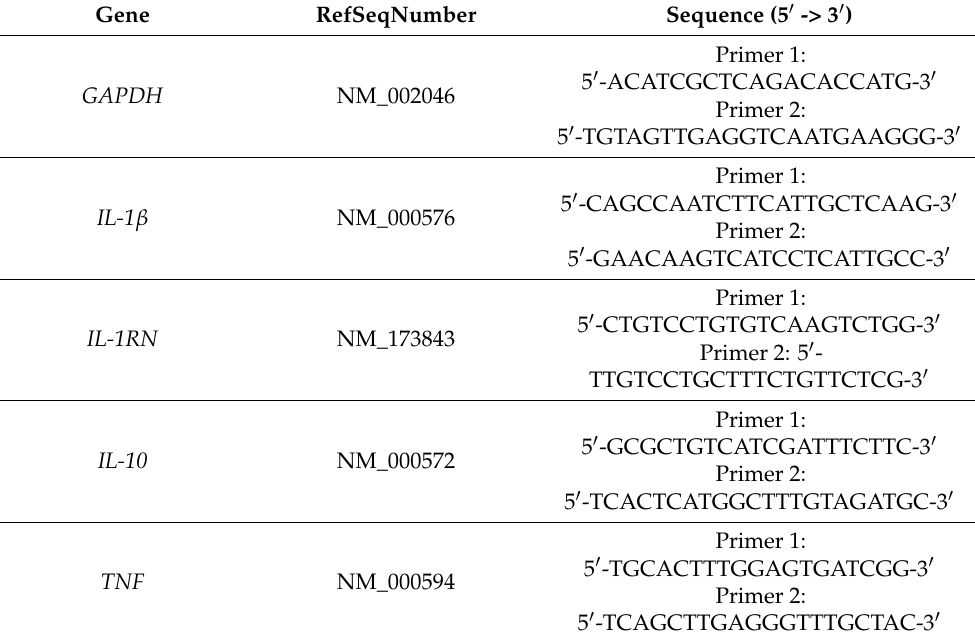
Table 1. Primer sequences used in real-time qPCR for gene expression